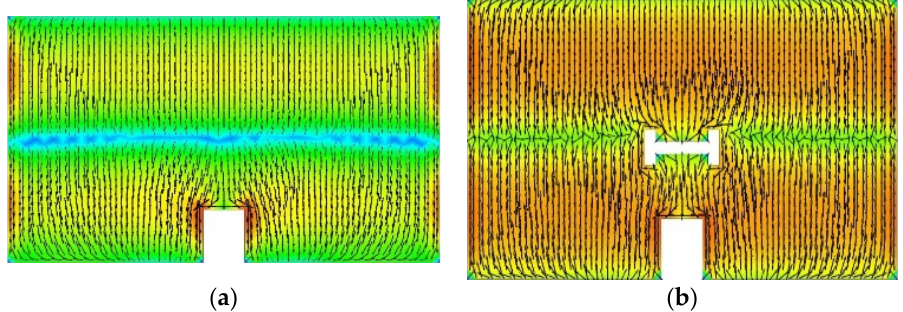
Figure 9. Current distribution of the TM02 mode. ( a ) Conventional patch antenna. ( b ) Proposed H- slot antenna.